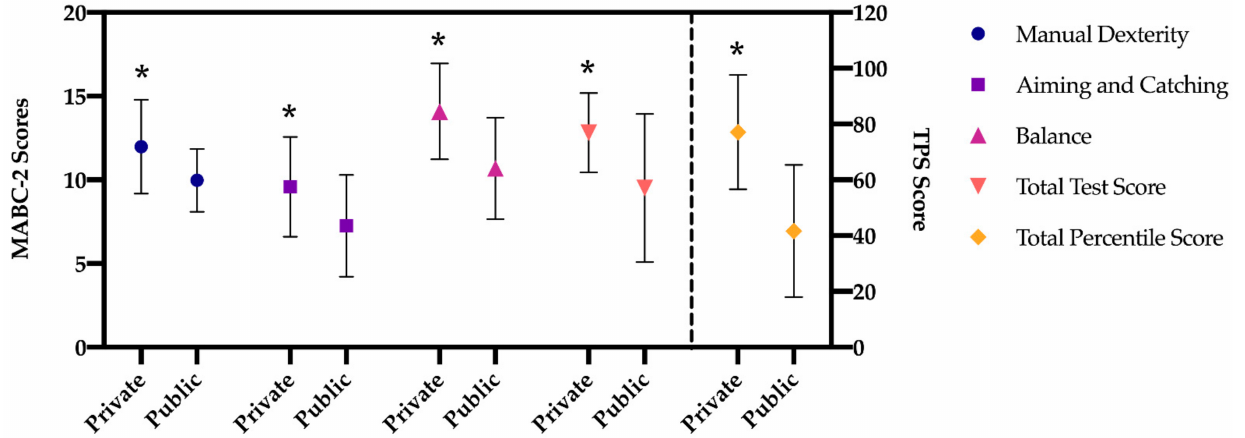
Figure 1. Differences in MABC-2 scores between private and public schools. Note: scores (range: 1–19); TPS score (range: 0.01–99.9); * p < 0.001.